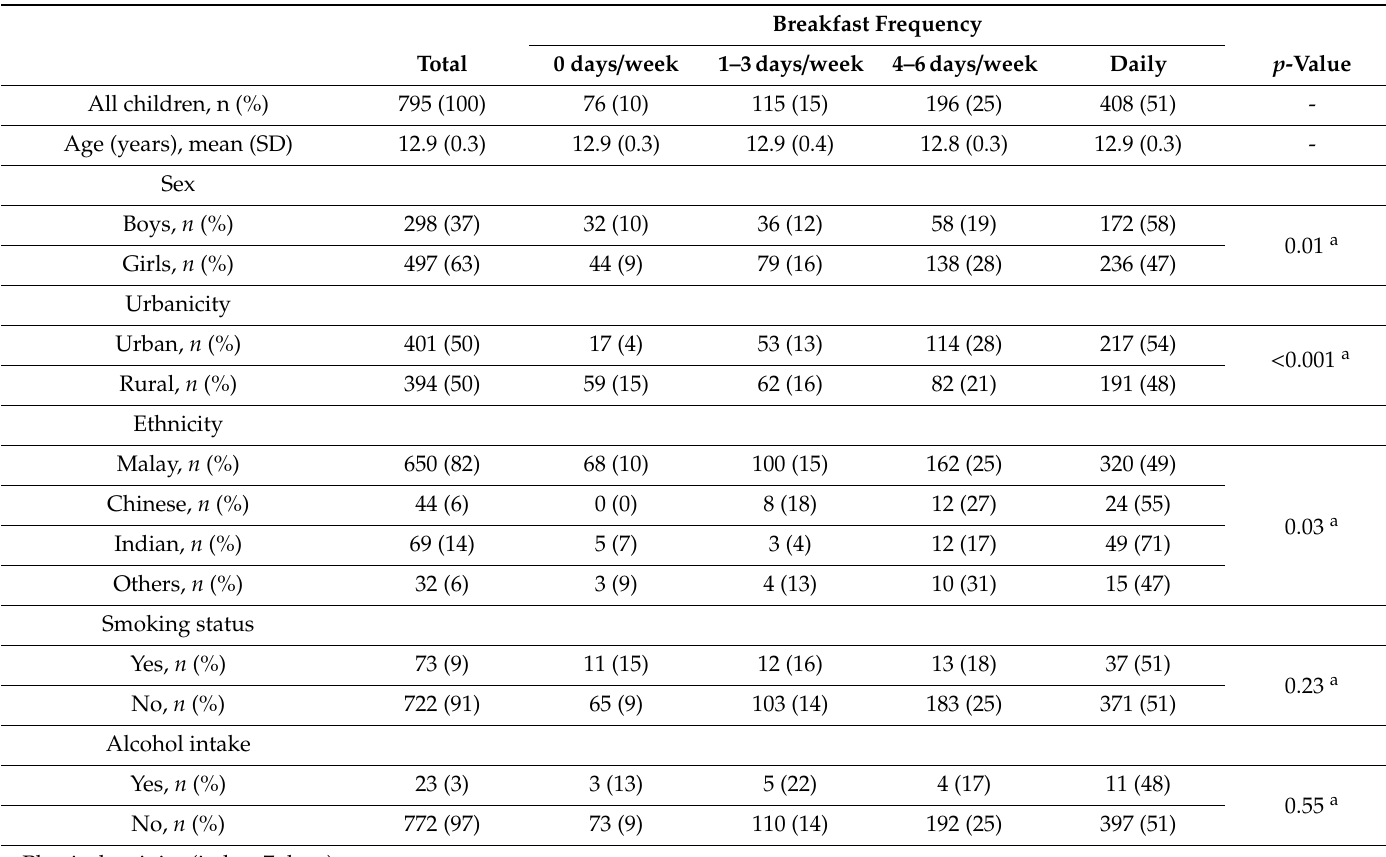
Table 1. Characteristics of MyHeARTs participants by breakfast frequency